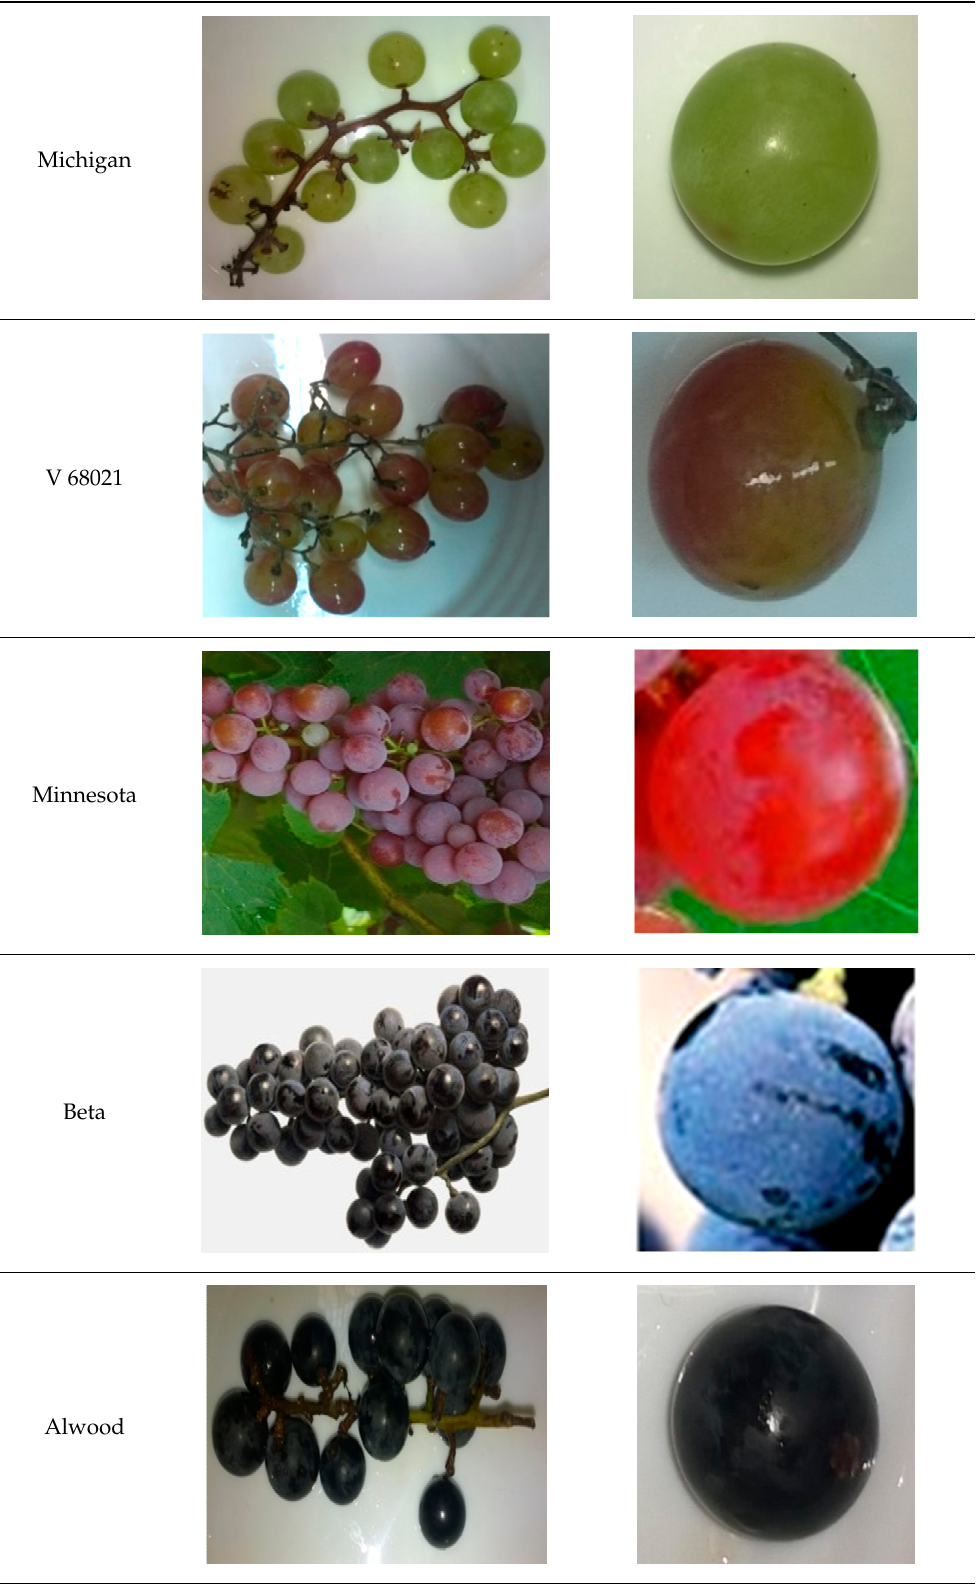
Table 1. Morphocharacteristcs of grapes variety.